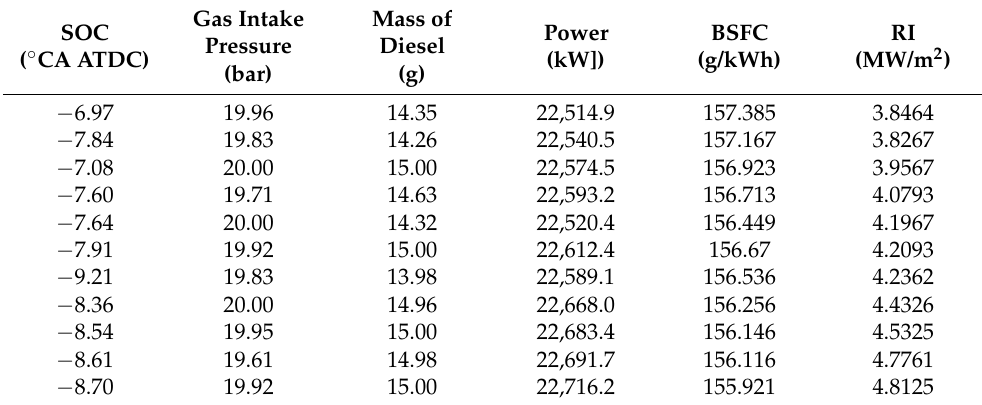
Table 8. The filtered optimized solution